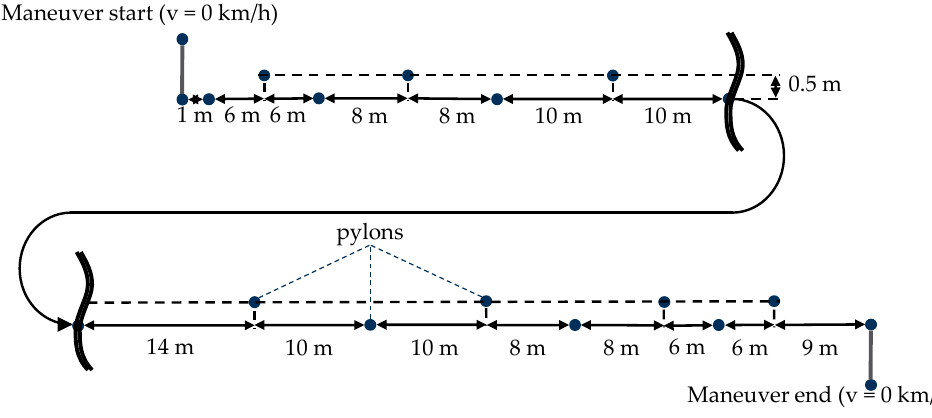
Figure 6. Schematic representation of Maneuver B (not to scale).